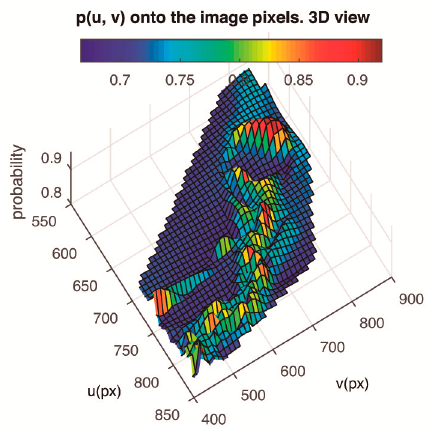
Figure 2. Probability distribution of feature matching existence, p(x,y,z) , projected onto the image pixels, p(u,v) .